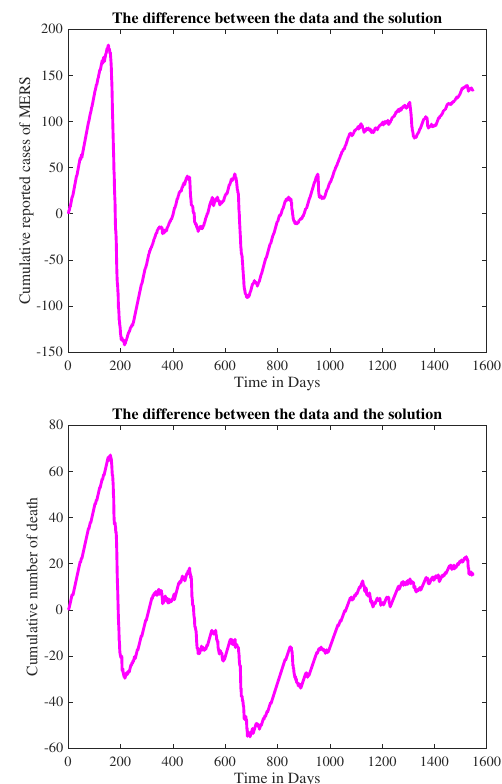
Fig. 10: Saudi Arabia: The difference between the data and the